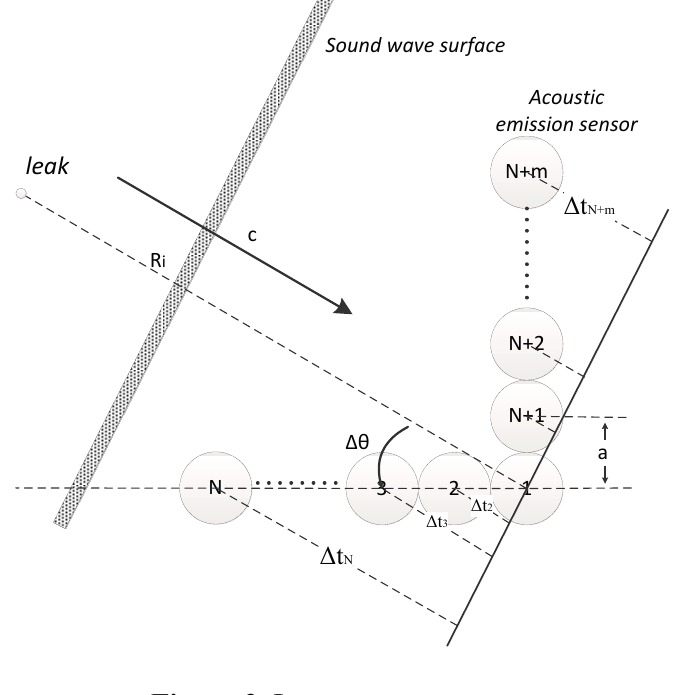
Figure 2. L-type sensor